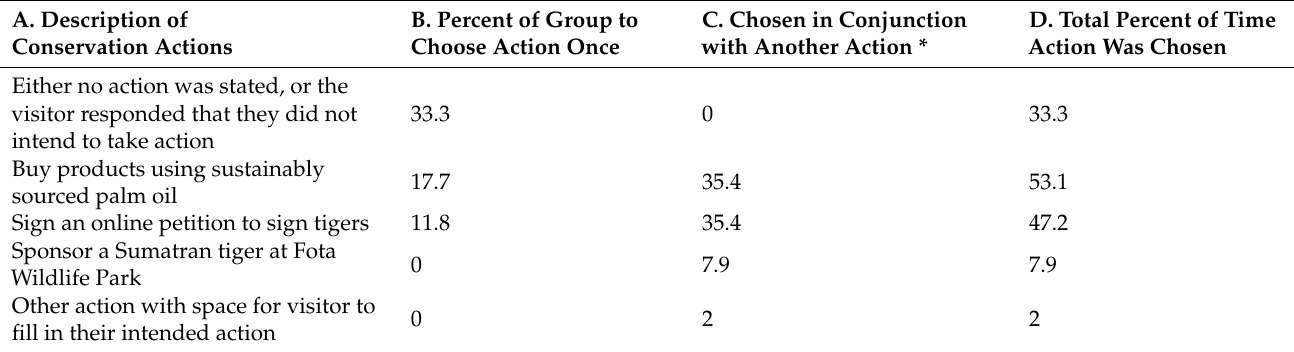
Table 3. Results of visitor pledge during the interactive tiger experience at Fota Wildlife Park showing (A) a description of the conservation actions, (B) percent of visitors to choose that action, (C) percent of visitor to choose action in conjunction with another action and (D) total percentage of times the respondents chose each